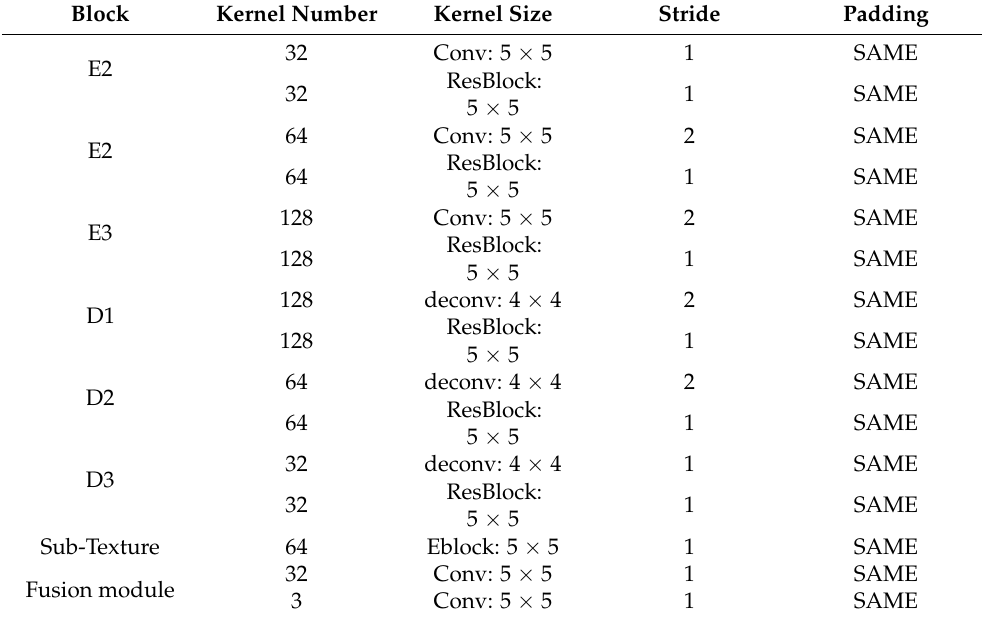
Figure 3. An overview of IDC structure. Table 1. Network Parameters.